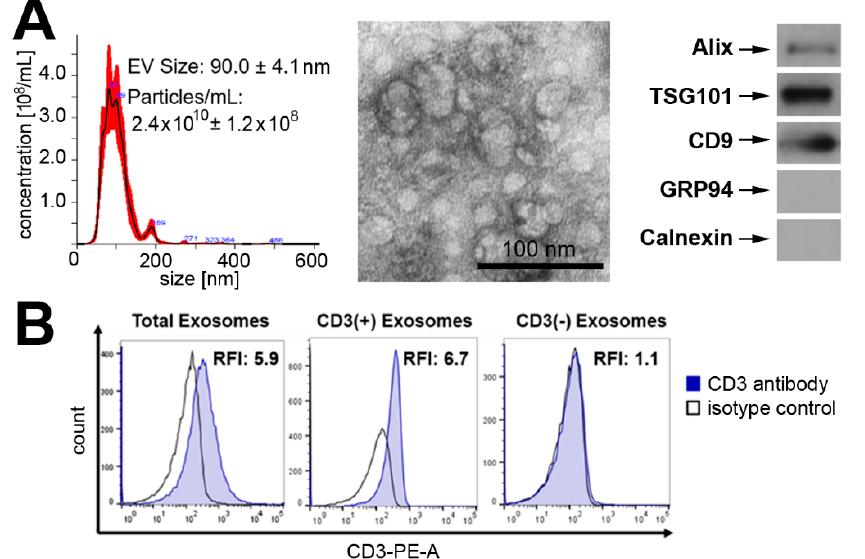
Figure 1. The characteristics of the analyzed vesicles: ( A ) the size, morphology and presence of ex- osome markers (from left to right), as analyzed by NanoSight, TEM and Western blots, respectively, in the total sEVs that were purified from the plasma; ( B ) the presence of CD3 in the CD3(+)exo and CD3( − )exo fractions, as analyzed by on-bead flow cytometry. RFI, MFI sample/MFI isotype control; TCR, T cell receptor CD3.